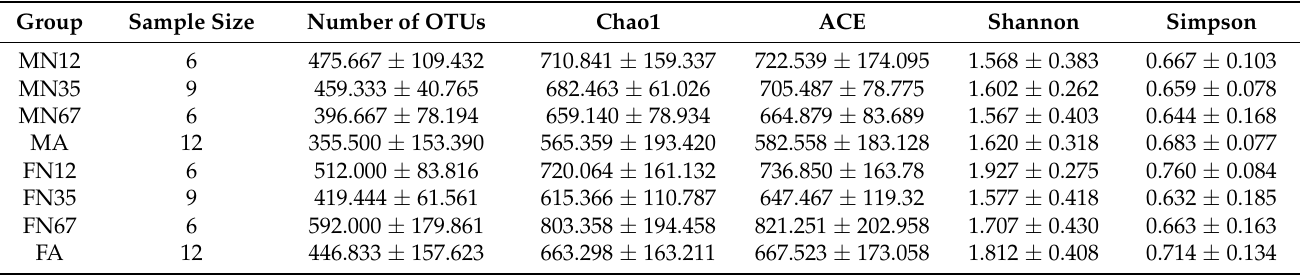
Figure 2. The alpha diversity of bacterial composition in Gampsocleis gratiosa fecal samples. ( A ) ACE, ( B ) Chao1, ( C ) Shannon, ( D ) Simpson. Table 4. Alpha diversity indices (Mean ± SD) of bacterial community in feces across Gampsocleis gratiosa ’s different developmental stages and